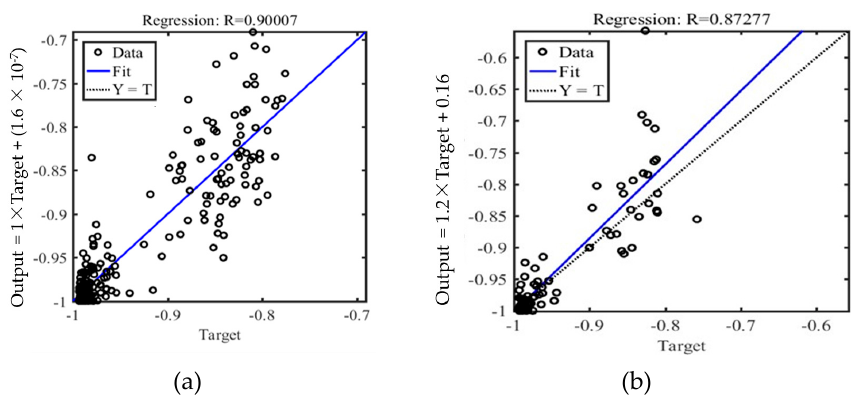
Figure 6. Comparison of the ANFIS outcomes with the actual data for the ( a ) training and ( b ) testing data set.